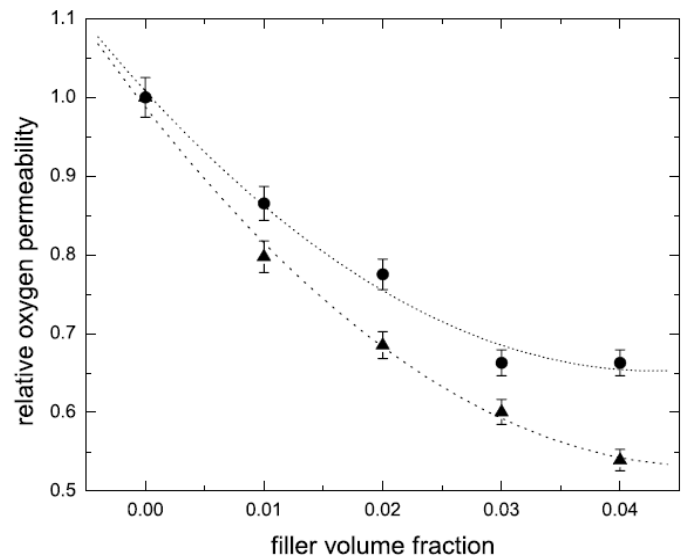
Figure 41. Oxygen barrier properties of polypropylene nanocomposites as a function of filler volume fraction. The montmorillonites have been modified with ammonium based ( ● ) and imidazolium based ( ▲ ) modifications. Reproduced from reference 50 with permission from Elsevier.